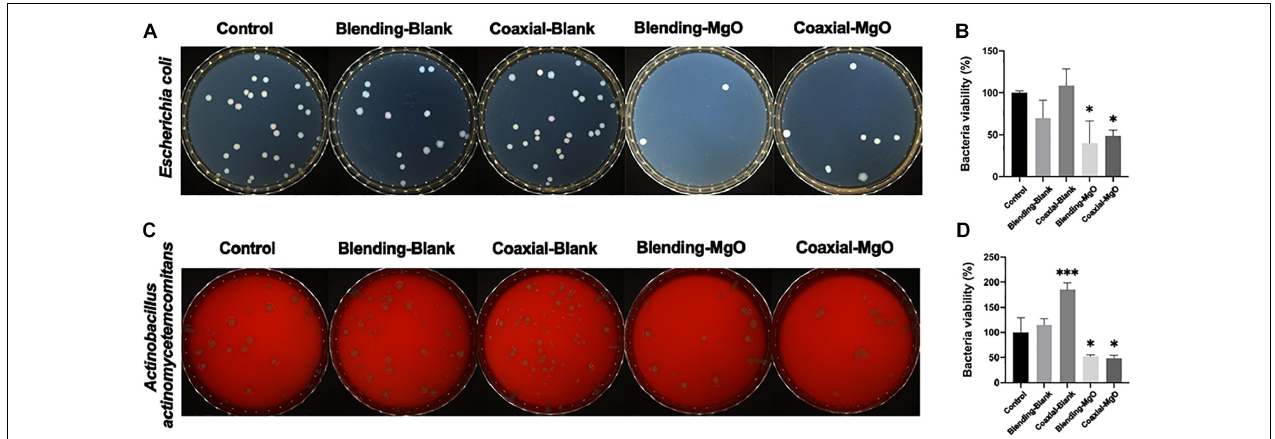
FIGURE 6 | Antibacterial activity of various kinds of electrospun membranes against E. coli and A. a. Digital pictures of bacterial colony forming units and their corresponding quantitative bacterial survival rate for (A,B) E. coli and (C,D) A.